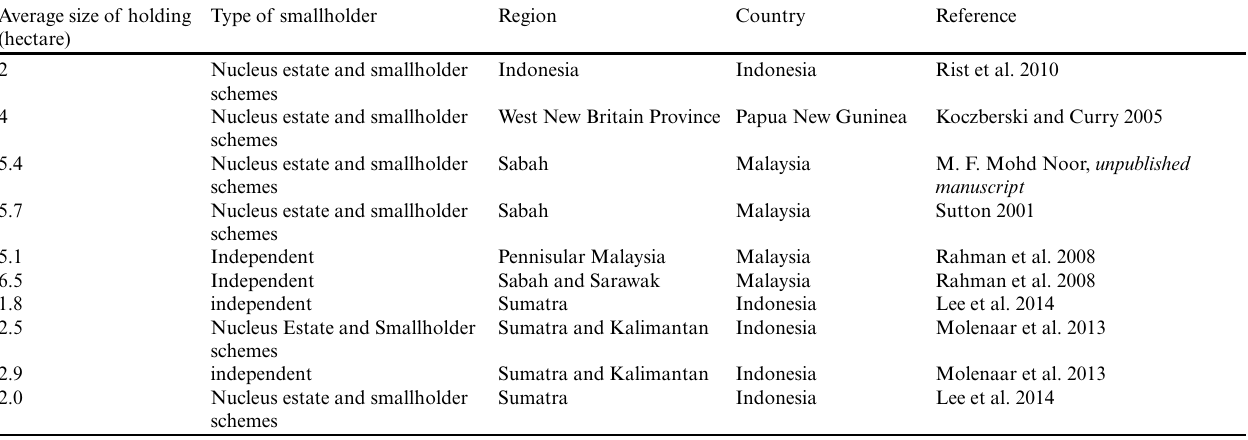
Table 2 . Overview of average land holding sizes (hectare) of smallholder oil palm growers in Indonesia and Malaysia. Average size of holding